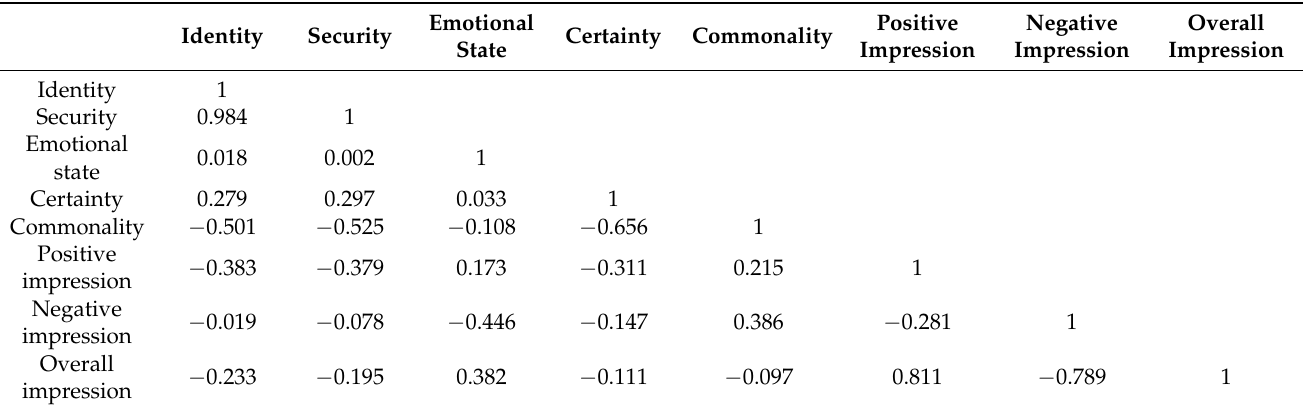
Table 3. The correlation matrix for the measures of general attitudes [6].